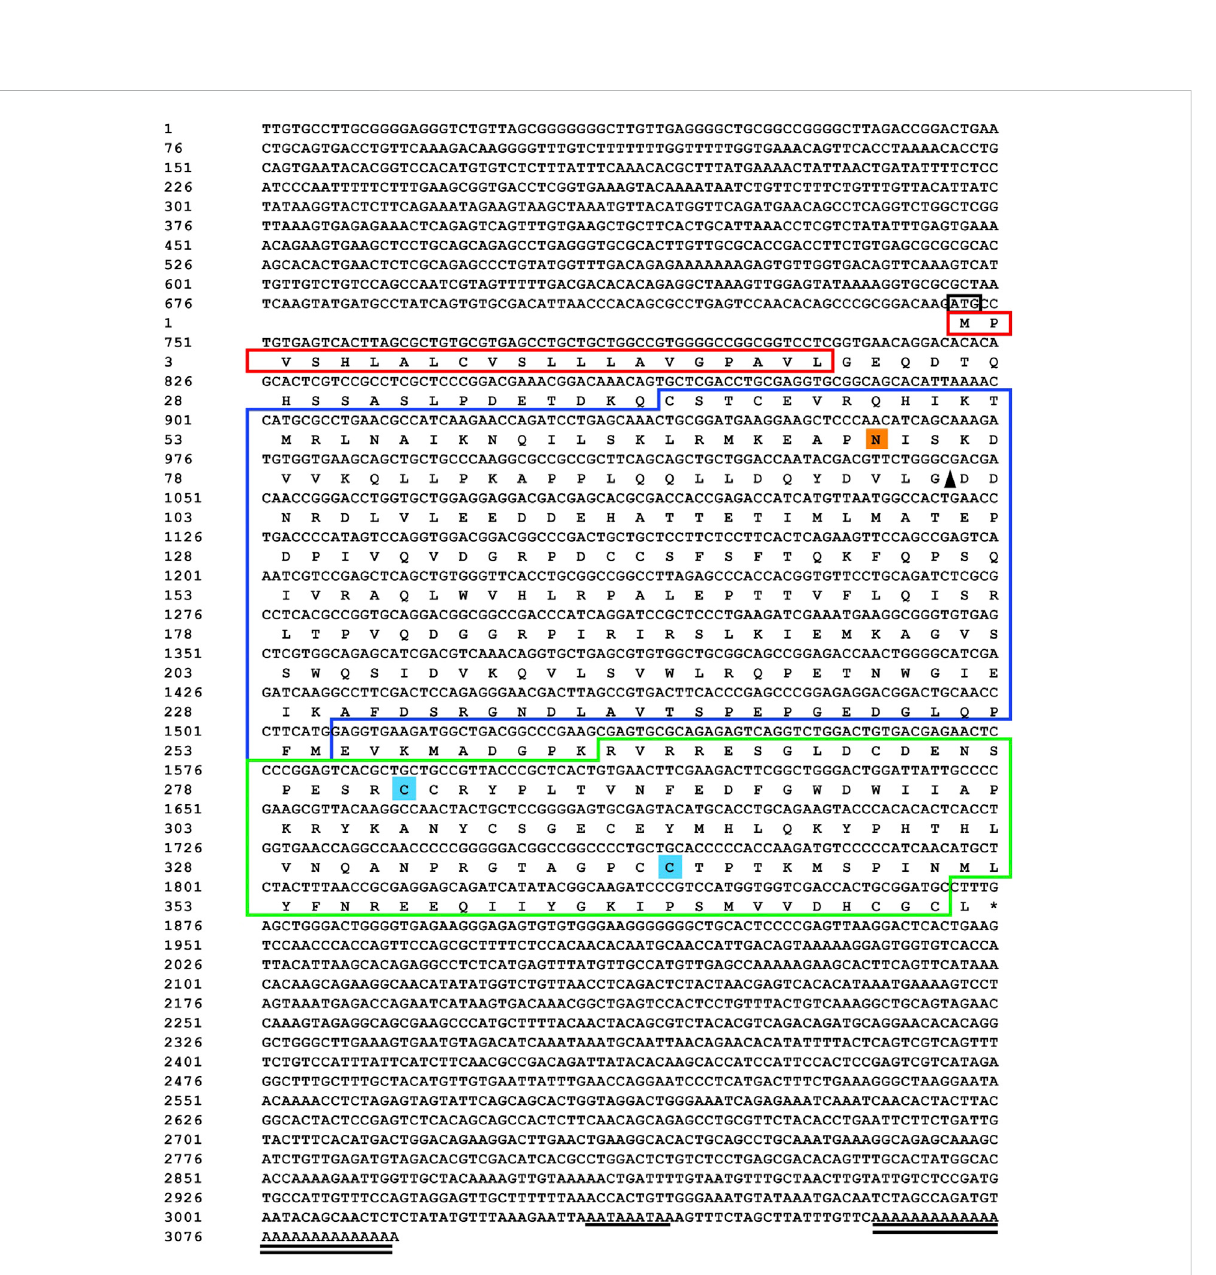
FIGURE 2 Sequencing results and amino acid sequence analysis of MSTN in Odontobutis potamophila. The black box indicates the ATG start codon; * indicates the termination codon; underlines indicate the Poly(A) plus tail signal; double underlines indicate the poly(A) sequence; red shading indicates possible signal peptide regions; blue shading indicates possible TGF β binding structural domains; green boxes indicate three possible repetitive follistatin structural domains; orange boxes indicate three duplicated Kazal structural domains; purple shading indicates possible nuclear localization signals; and yellow shading indicates possible N-glycosylation